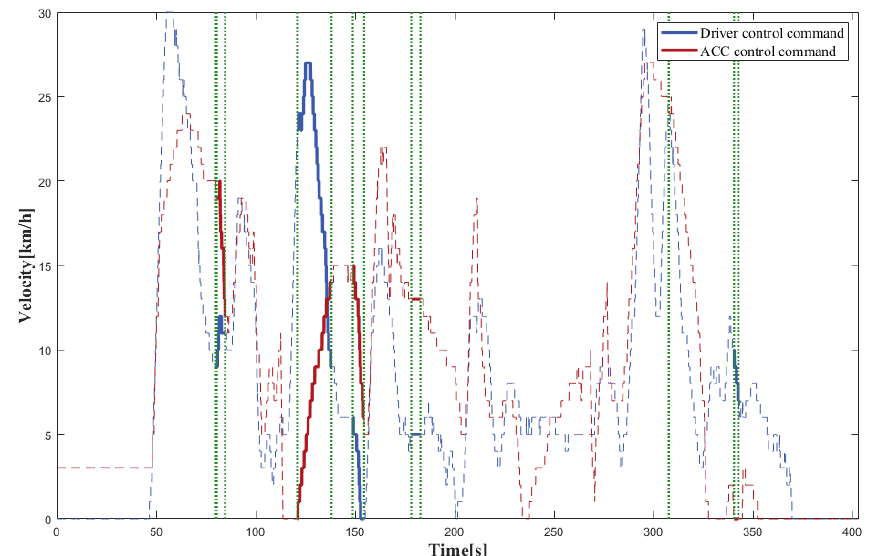
Figure 15. The results for real vehicle Figure 15. Distance matrix and warping path visualization for the 1st round test.